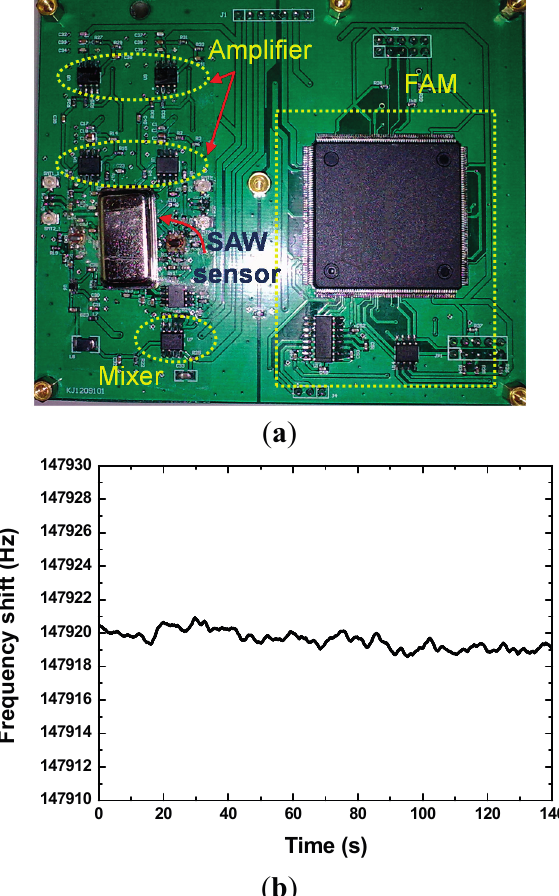
Figure 6. The PCB for the developed SAW sensor ( a ), and short-term frequency stability testing of SAW oscillator ( b